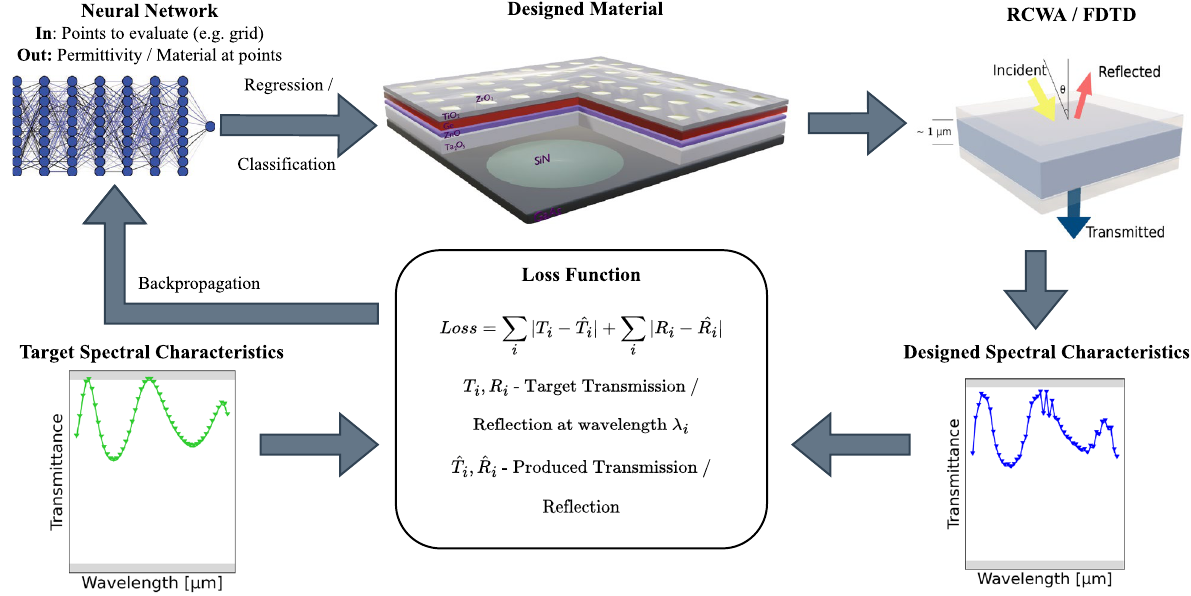
Figure 1. Training setup for NIDN; regression and classification as well as RCWA and FDTD are described in detail in